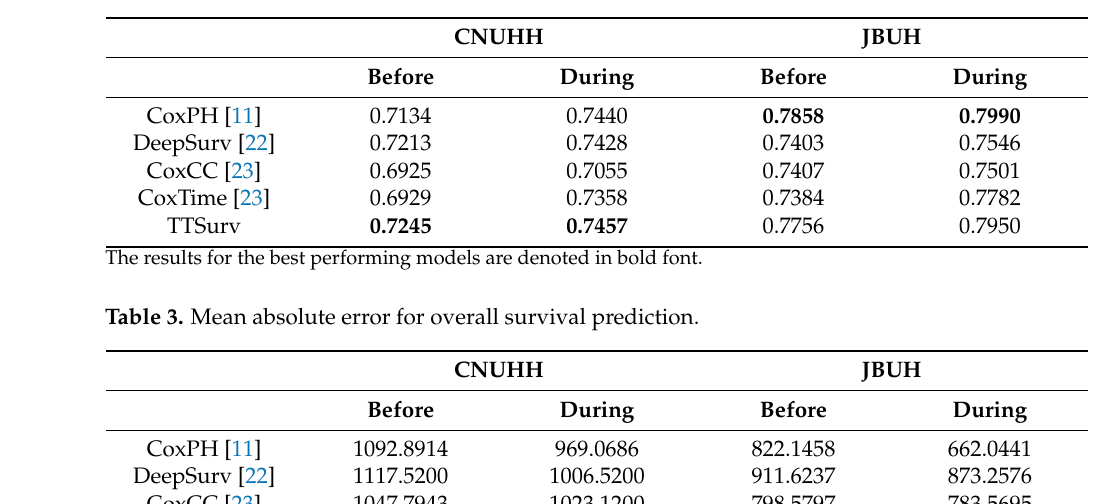
Table 2. Concordance index for overall survival prediction.